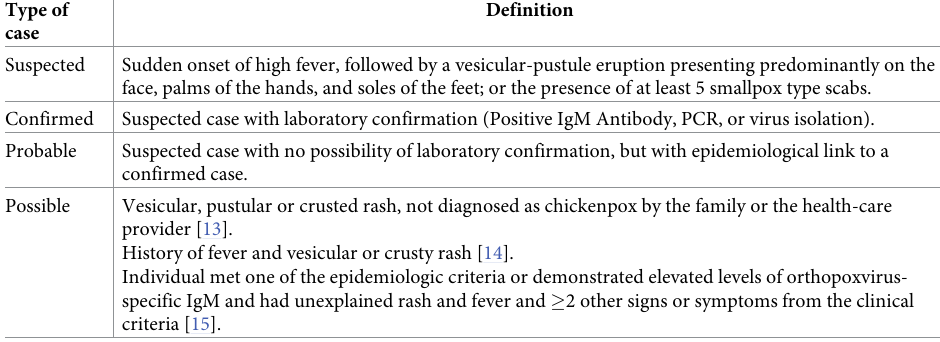
Table 1. Monkeypox Case